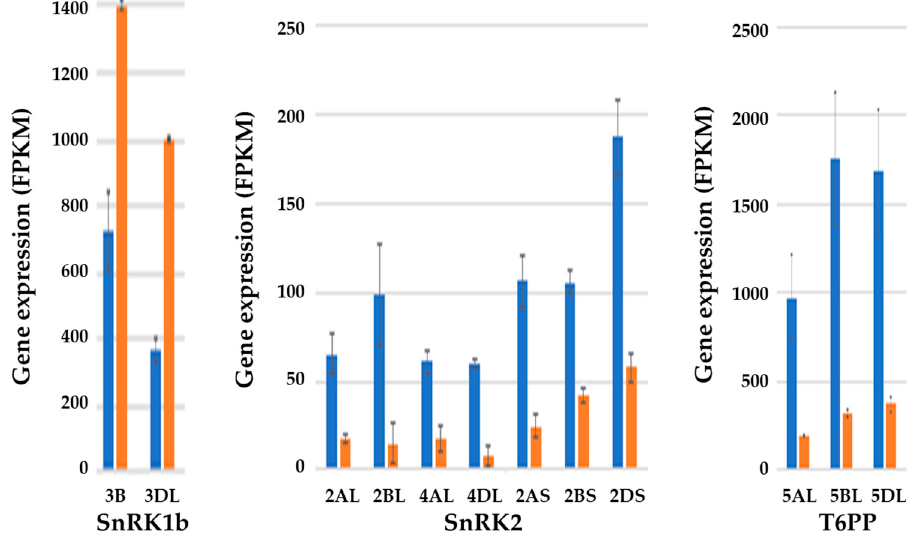
Figure 7. Graphical representation (means and standard errors) showing the effects of sulphur on the expression levels (FPKM) of selected genes in the endosperm of developing grain of wheat ( Triticum aestivum ) genotype SR3 at 21 days post-anthesis. Sulphur was either supplied (blue columns) or withheld (brown columns). Results for each homeologue are shown separately, with chromosomal locations indicated. ( Left panel ) SNF1-related protein kinase-1 ( SnRK1 ) type b. The increase in expression of both homeologues in response to sulphur deficiency was significant ( p < 0.01). ( Middle panel ) SnRK2 . The decrease in expression of all homeologues of all three genes in response to sulphur deficiency was significant ( p < 0.01 for 2AL and 2BS; p < 0.001 for all others). ( Right panel ) Gene encoding trehalose 6-phosphate (T6P)